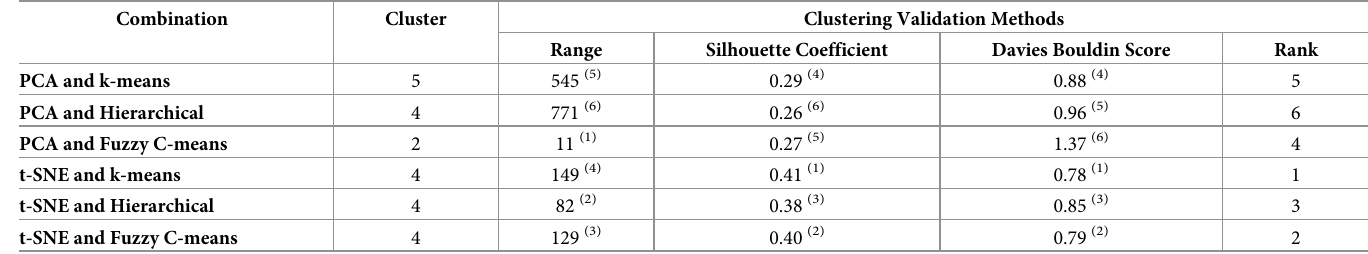
Table 1. The comparison of performance among different combination of dimensional reduction technique and clustering algorithm.